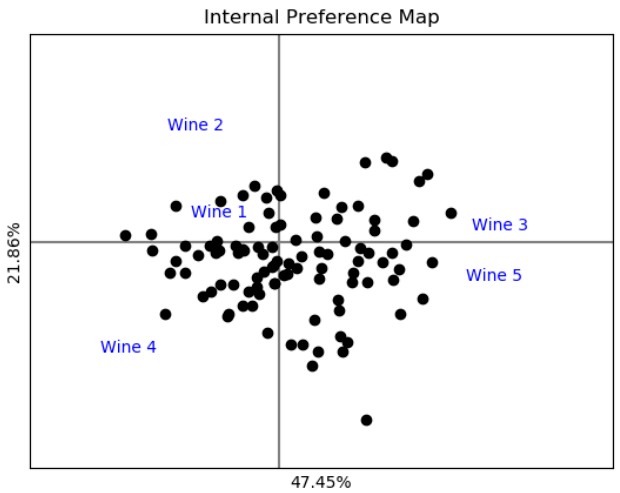
Figure 6. Internal preference mapping of experiment 2.